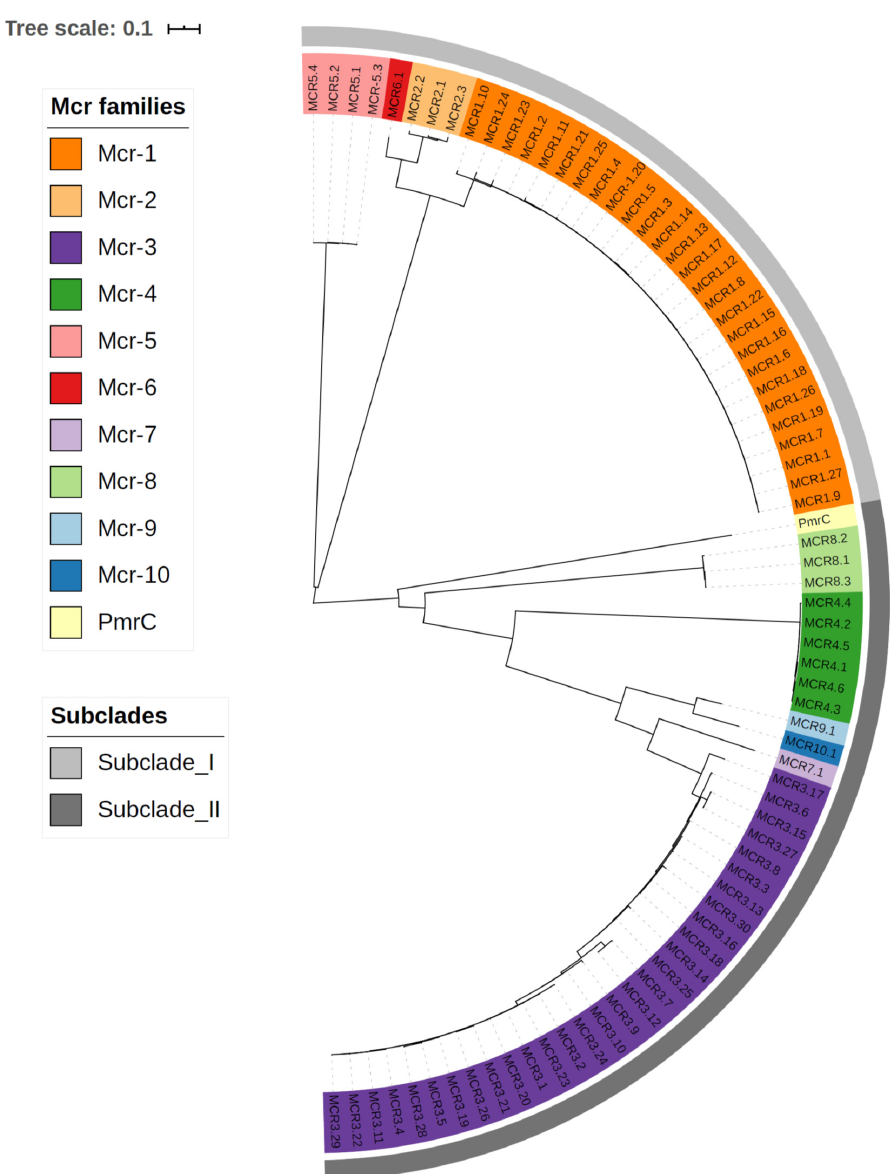
Figure 5. Maximum-likelihood phylogenetic tree based for the Mcr amino acid sequences (Table S1) and aligned using Seaview 4.0 [87]. The maximum-likelihood tree was obtained using PhyML as implemented in Seaview using the BLOSUM62 substitution matrix allowing for across site rate variation. The tree was annotated using the Interactive Tree of Life online tool [88].